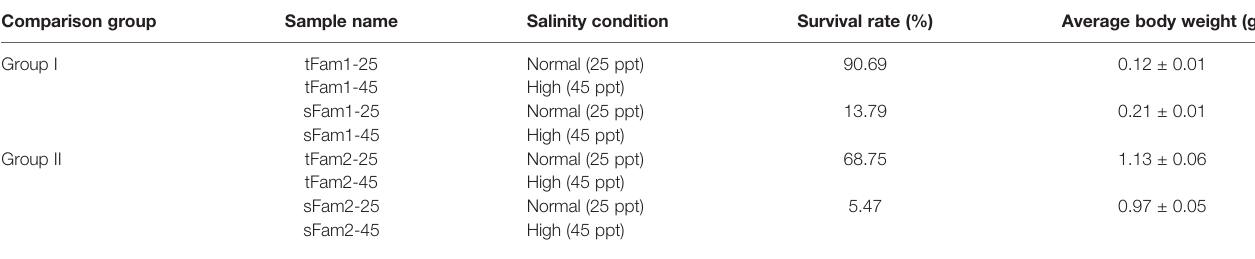
TABLE 1 | Information of four families used for transcriptome sequencing. Comparison